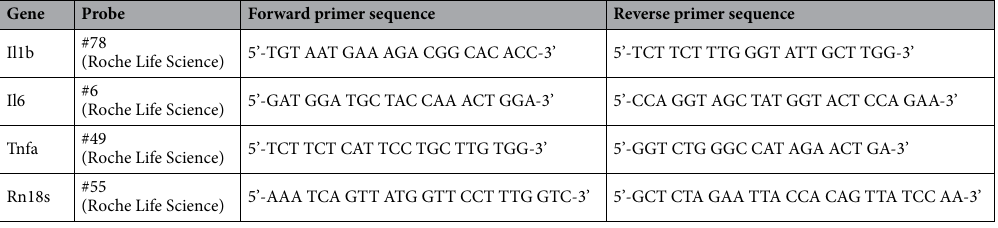
Table 1. Primers and probes used for real-time